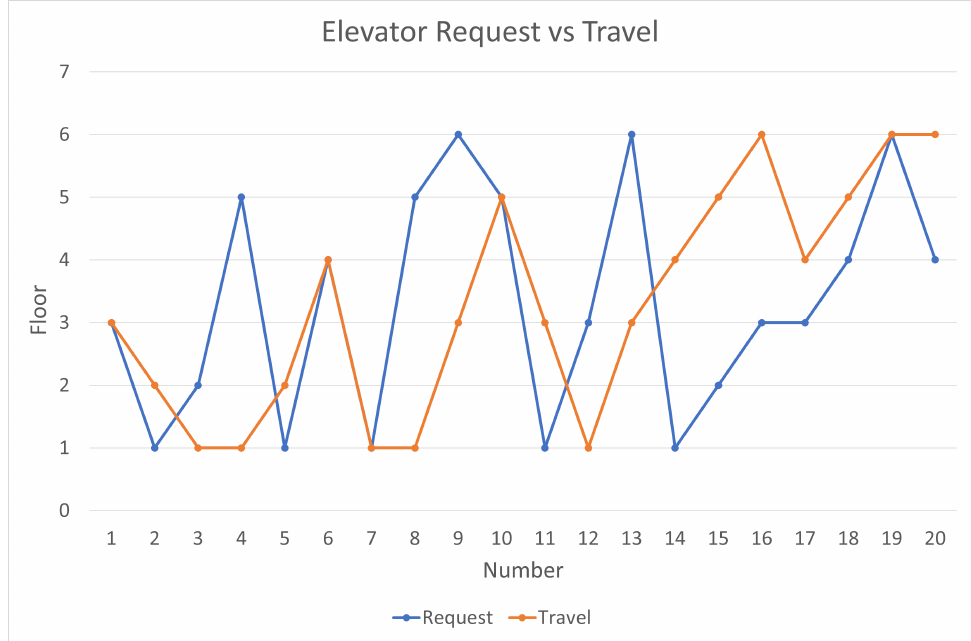
Figure 8. The path of the requested path compared to the optimised path of the elevator.